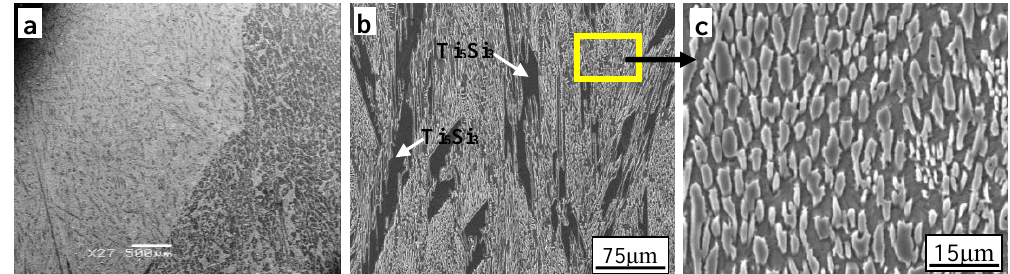
Figure 1. Microstructure of the Ti–20%Si alloy cast in metal mold showing ( a ) large grains; ( b ) a coarse primary Ti 5 Si 3 phase; and ( c ) the eutectic matrix.